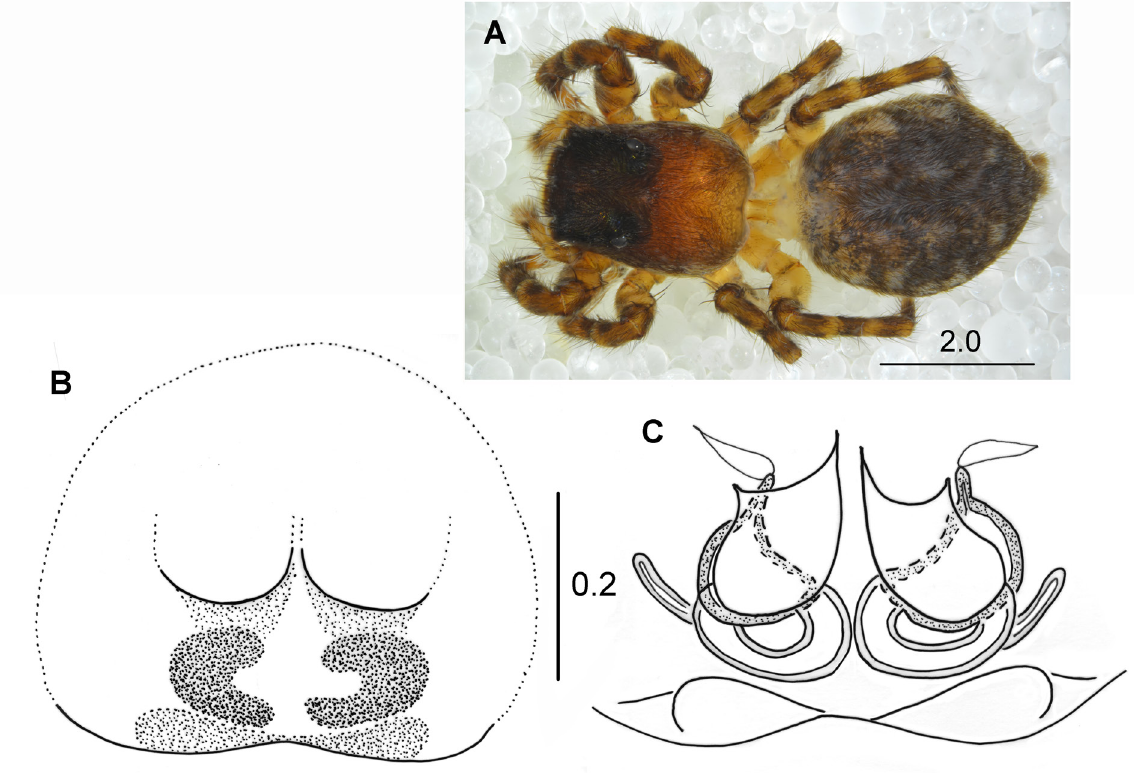
Fig. 35. Menemerus niangbo sp. nov., holotype, ♀ (MNHN). A . Habitus, dorsal view. B . Epigyne. C . Internal structure of